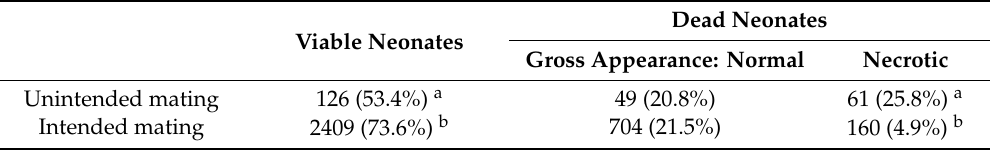
Table 6. The general health of newborns obtained from bitches presented with dystocia, in which pregnancy was a result of unwanted mating (pregnancies: n = 75 *, neonates: n = 236) and in intended matings (pregnancies: n = 838, neonates: n =